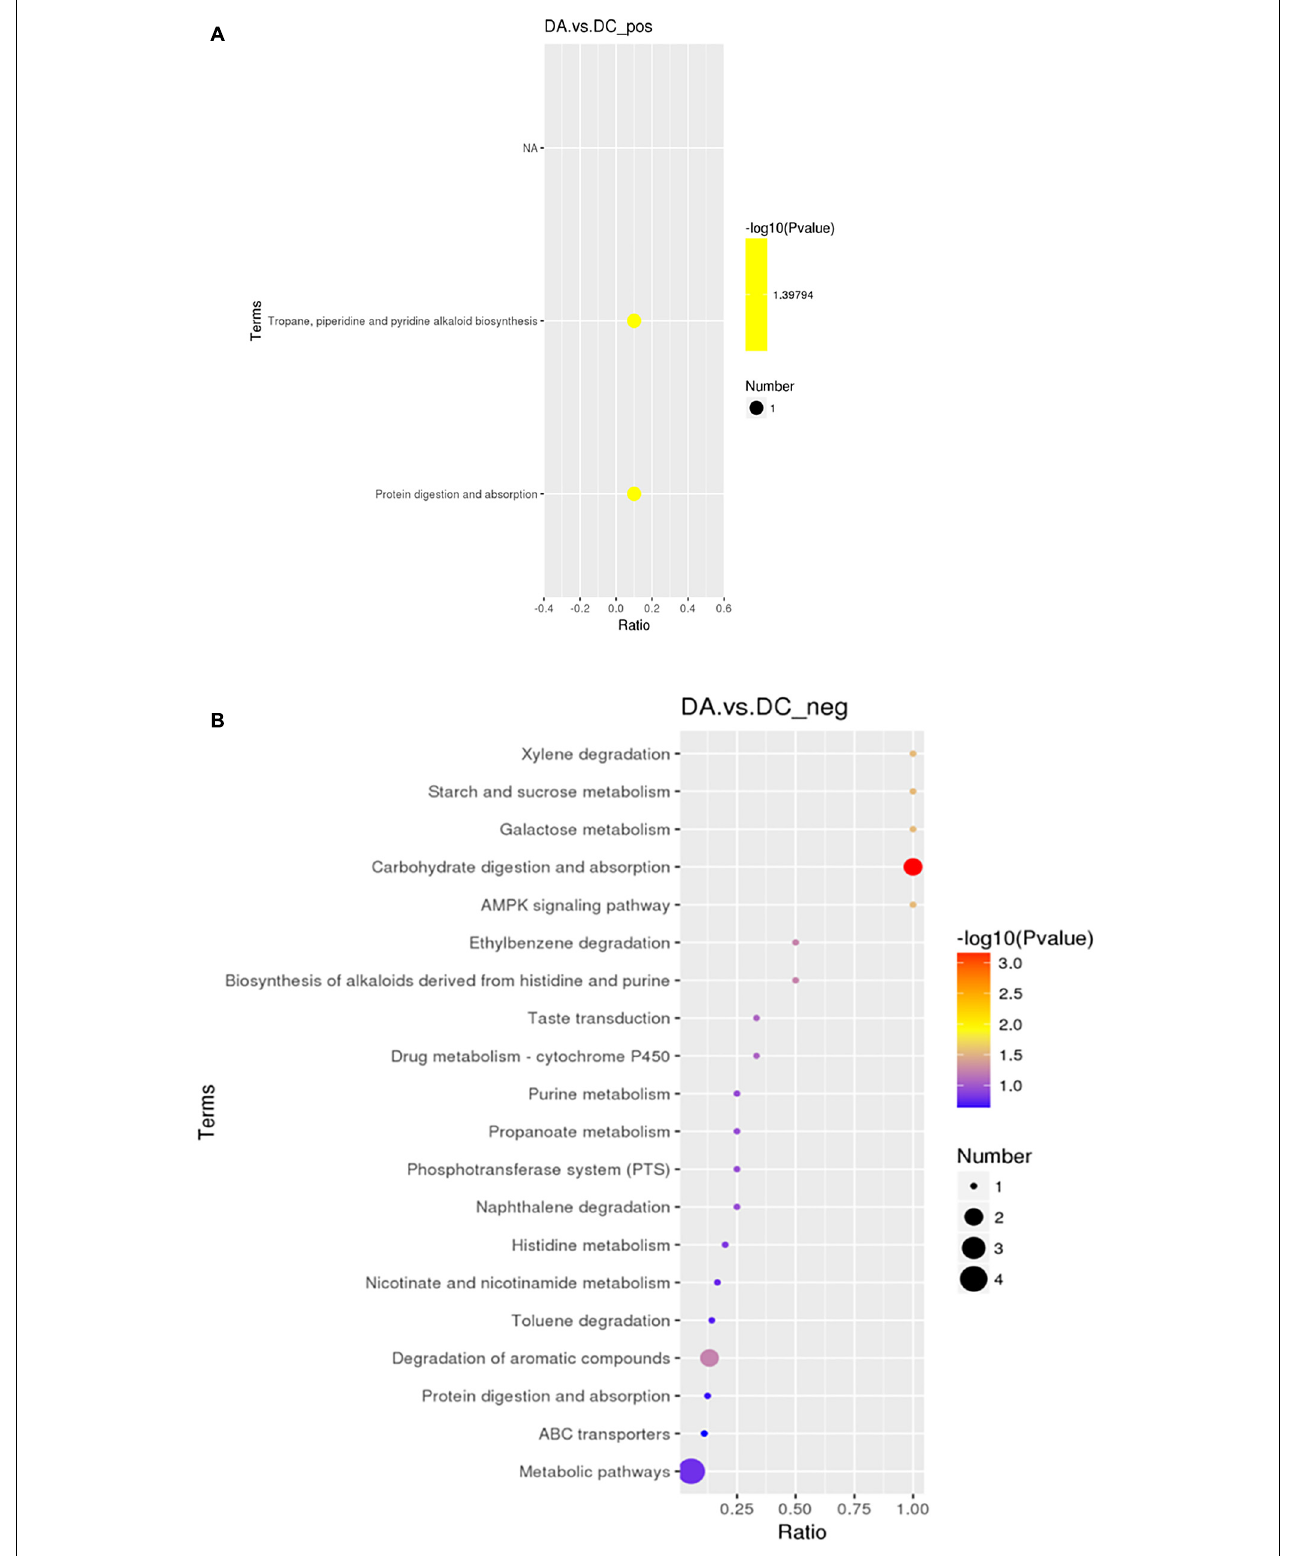
FIGURE 10 | The KEGG enrichment map. (A) Positive ion mode and (B) negative ion mode.